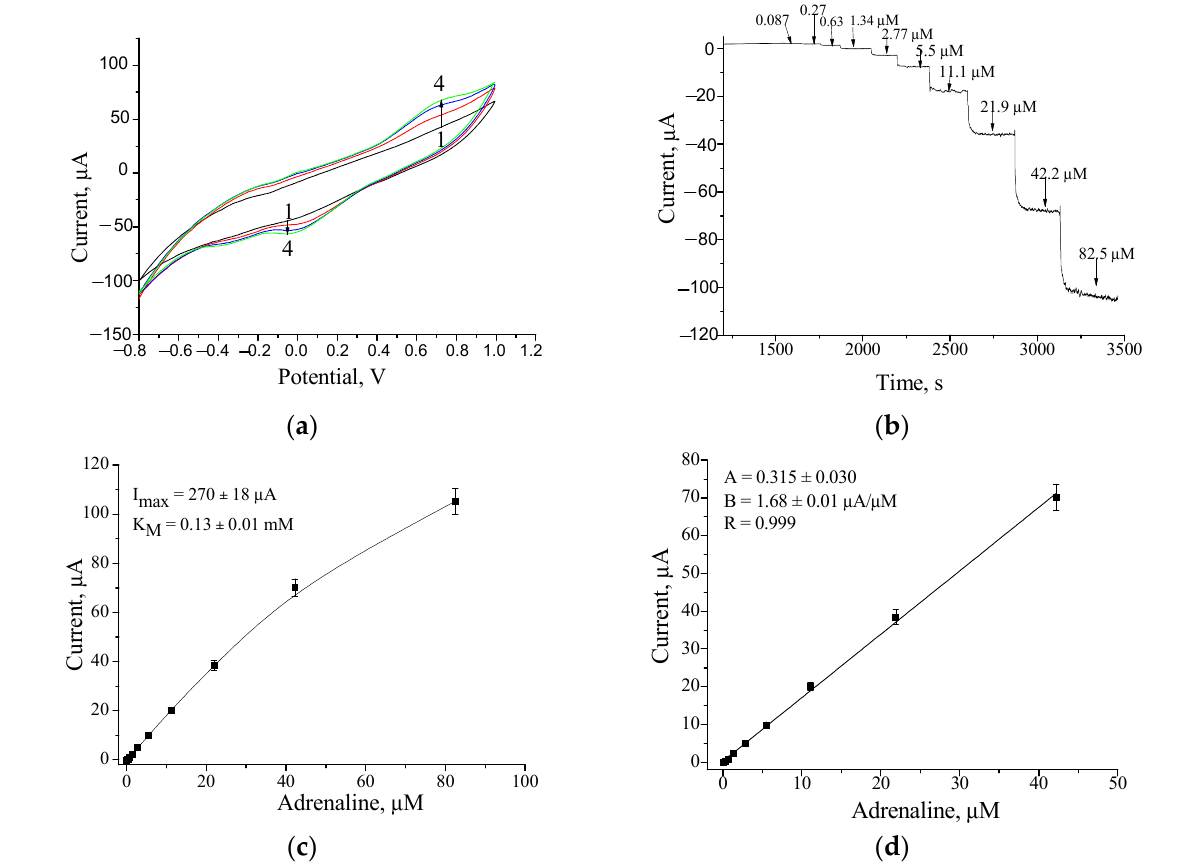
Figure 3. Characteristics of nAuCePt/GE: CV as current responses upon AD addition up to 0 mM (1, black line), 4 µM (2, red line), 8 µM (3, blue line), and 16 mM (4, green line) concentrations ( a ); chronamperometric response ( b ), dependence of amperometric signal on concentration of AD ( c ) and calibration graph ( d ) under working potential − 50 mV. Table 2. Analytical characteristics of the developed laccase-like NZ/GE as chemosensors for adrenaline in comparison with the known sensors for AD